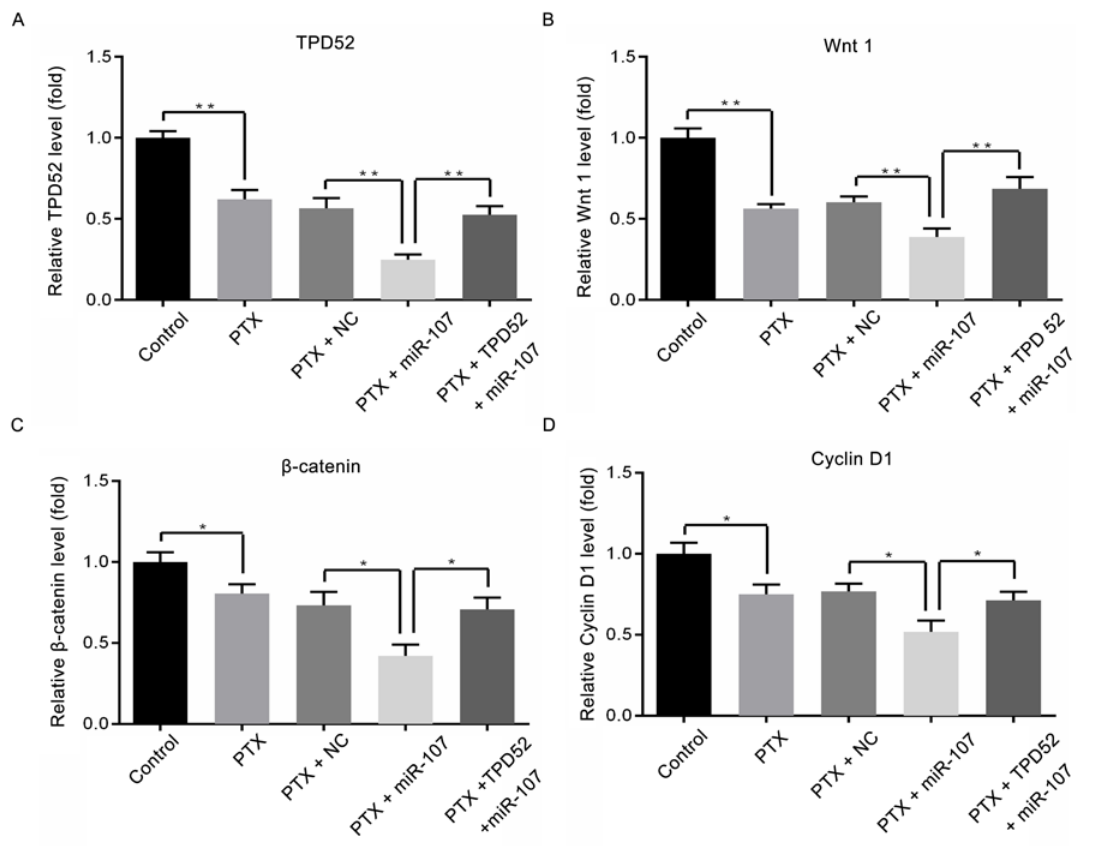
Figure 8: Effect of miR-107 on the mRNA expression levels of TPD52, Wnt1, β-catenin and cyclin D1. (A) The mRNA expression level of TPD52 in different groups; (B) The mRNA expression level of Wnt 1 in different groups; (C) The mRNA expression level of β-catenin in different groups; (D) The mRNA expression level of Cyclin D1 in different groups. *P<0.05, **P<0.01, PTX vs control; PTX + miR-107 vs PTX + NC; PTX + TPD52 + miR-107 vs PTX +miR-107. Control, un-treated cells; PTX, cells were exposed to PTX with the concentration of 0.1μg/ml; NC, miR-107 mimics negative control-transfected cells; miR-107, miR-107 mimics-transfected cells; TPD52, tumor protein D52, cells transfected with